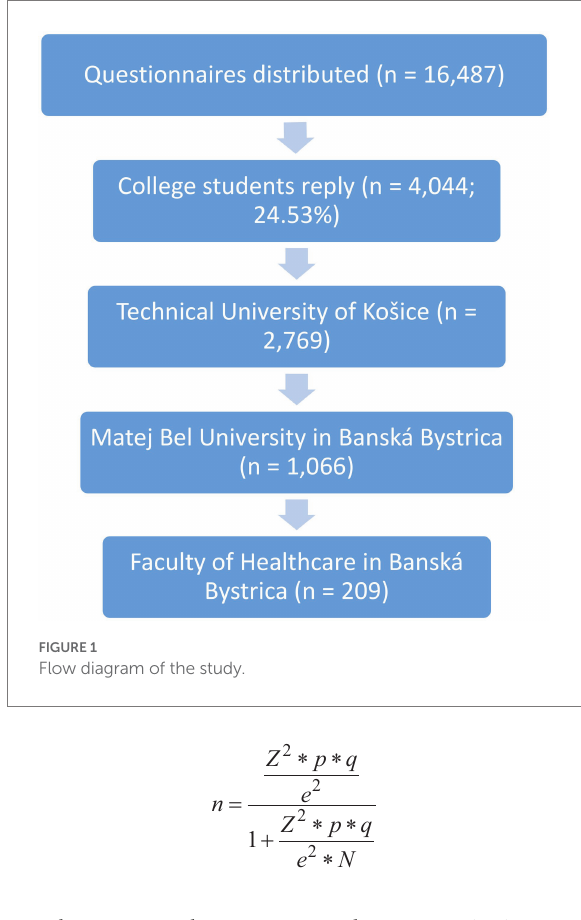
TABLE 1 Participants’ characteristics.